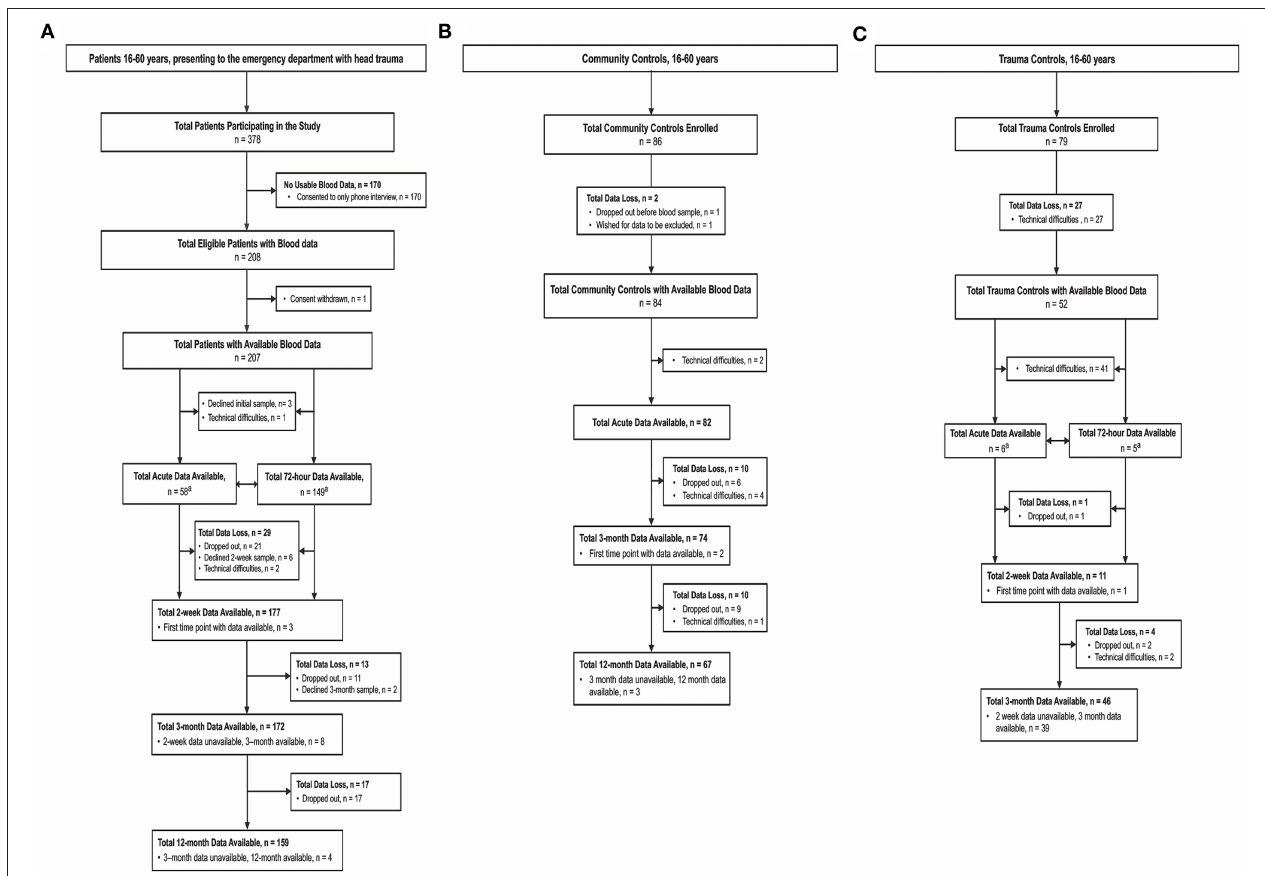
FIGURE 1 | Enrolment and follow-up of (A) patients with mTBI, (B) Community Controls, and (C) Trauma Controls. mTBI, mild traumatic brain injury; CT, computed tomography. a Acute and 72-h blood data are shown next to each other as these time points are largely